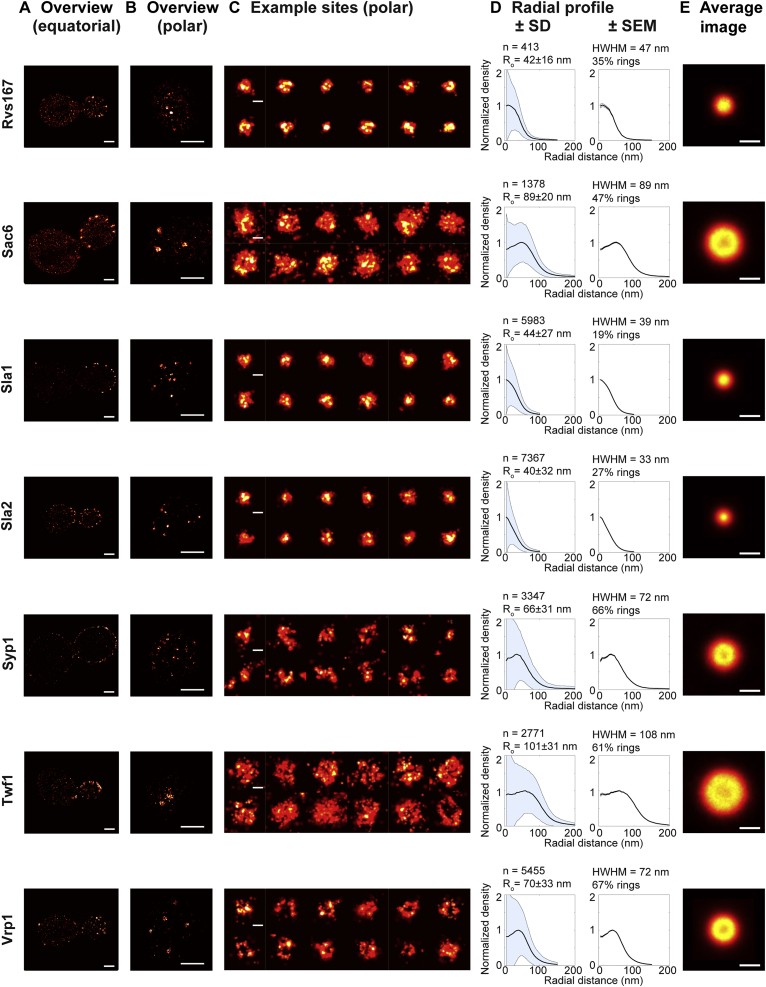
Overview of Imaged Endocytic Proteins (Part 3/3), Related to Figures 1 and 2(A–E) As in Figure S1. Scale bars 1 μm (A and B) or 100 nm (C and E).